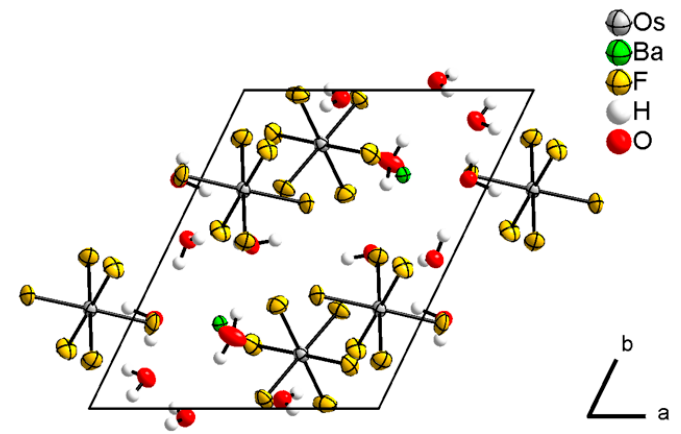
Figure 11. The crystal structure of Ba(OsF 6 ) 2 ∙ 6H 2 O (projection along c -axis). Displacement ellipsoids are shown at 70% probability level at 100 K. All the non-hydrogen atoms are shown anisotropic, hydrogen atoms are shown with arbitrary radii.